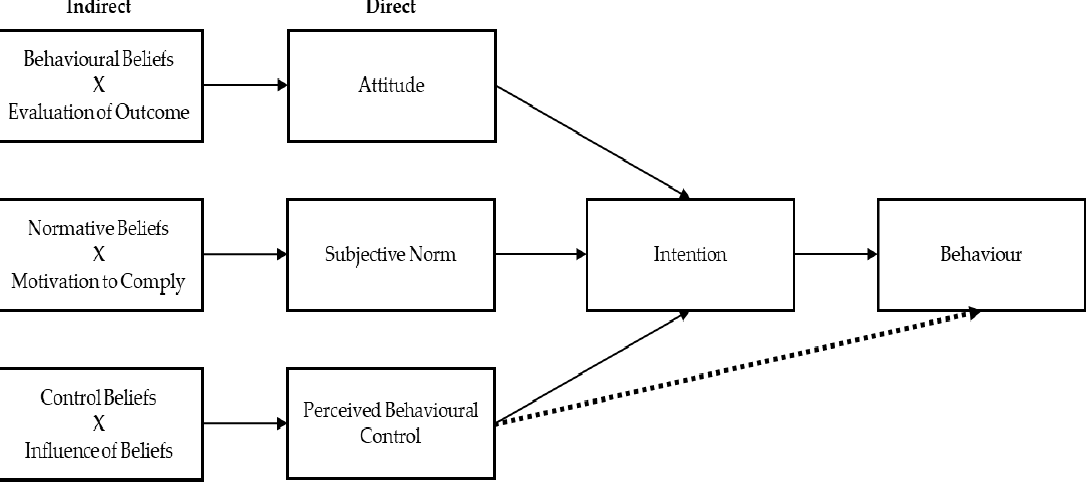
Figure 1. The theory of the planned behaviour (adapted from Ajzen, 2006; [62]).